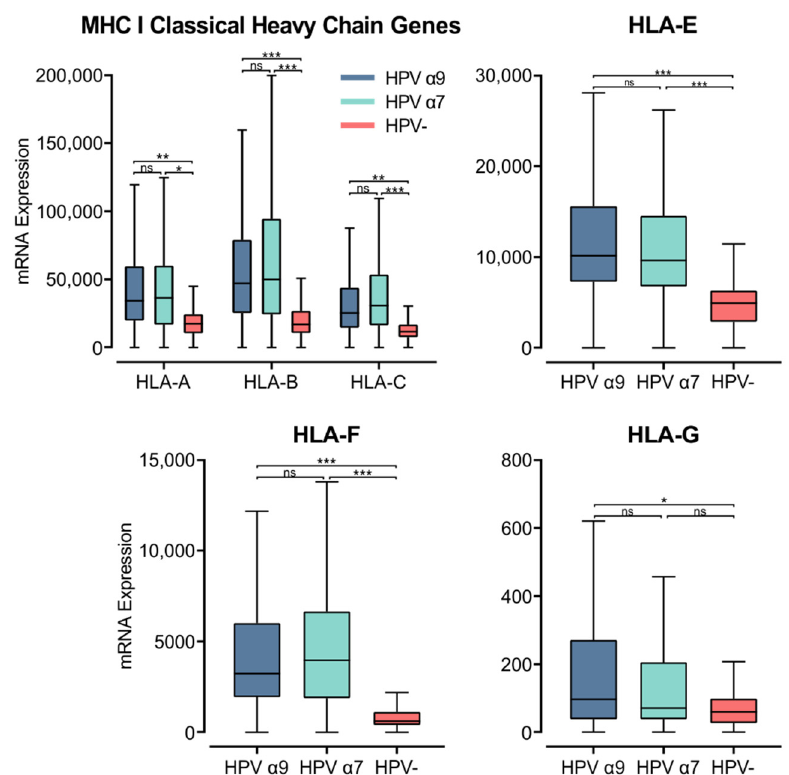
Figure 5. Expression of MHC class I classical and non-classical heavy chain genes in CC stratified by HPV+ ( α 9 or α 7) and HPV − status. Normalized RNA-seq data for MHC class I classical and non-classical were extracted from the CC cohort of the TCGA database. *** p ≤ 0.001, ** p ≤ 0.01, * p ≤ 0.05, ns (not significant).